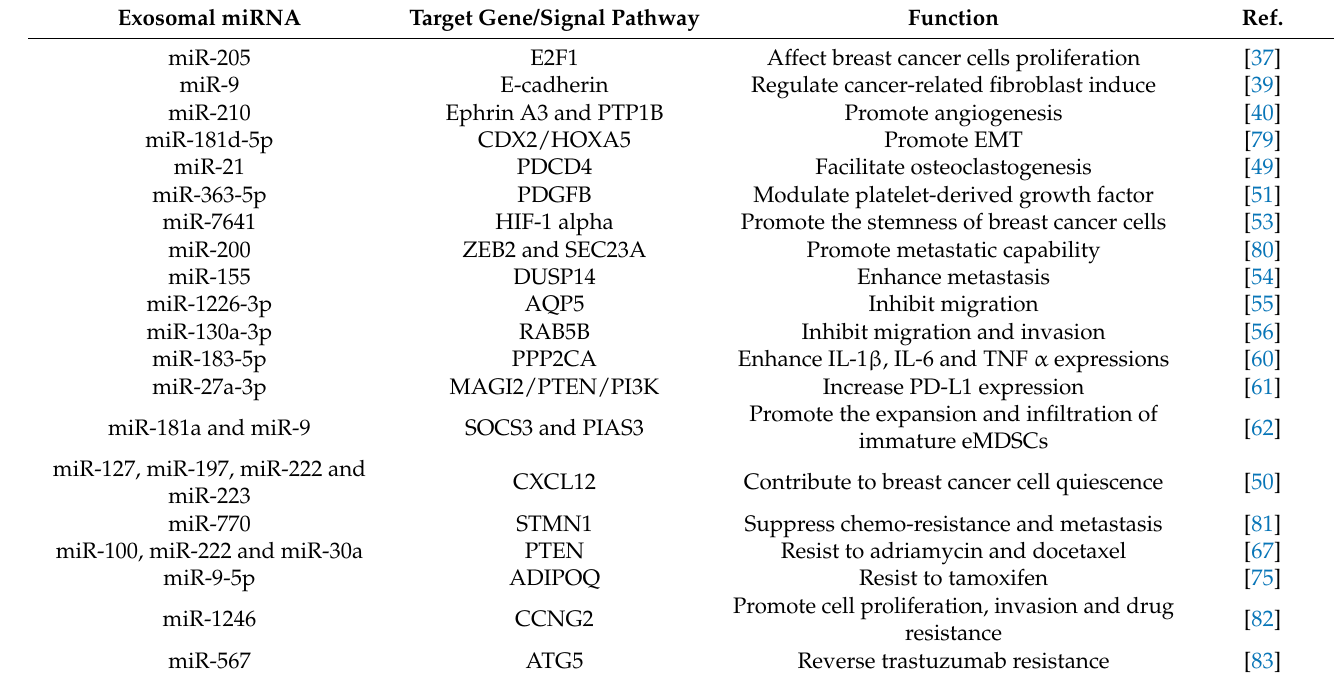
Table 1. Exosomal miRNAs involved in breast cancer